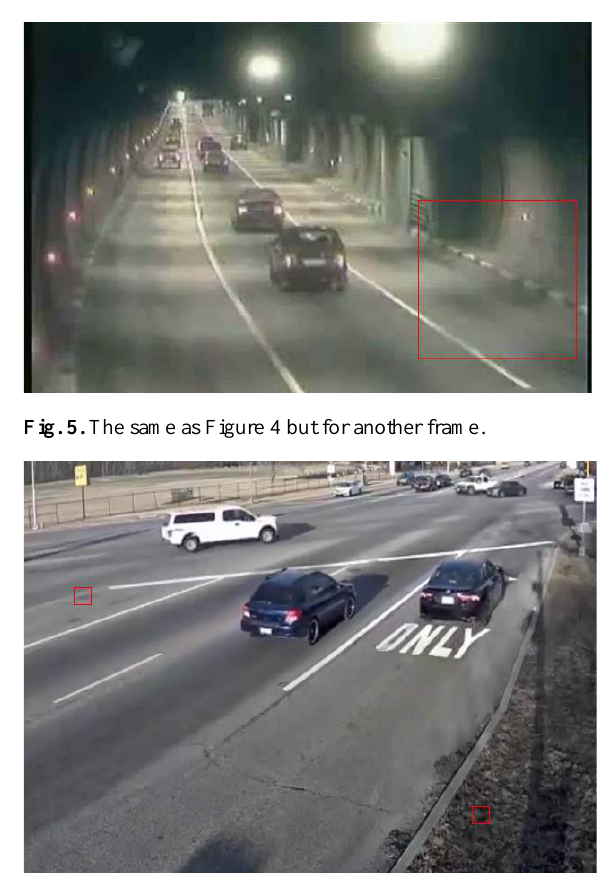
Fig. 4. Illustration of the ANN algorithm. Nothing is detected although there are vehicles to recognize.